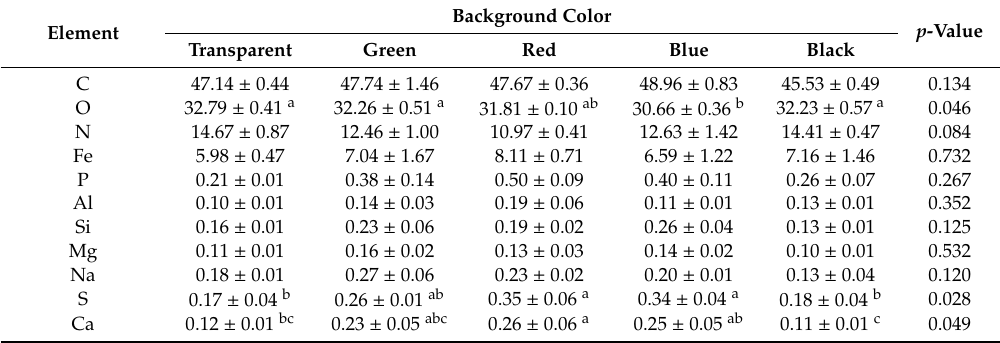
Background Color